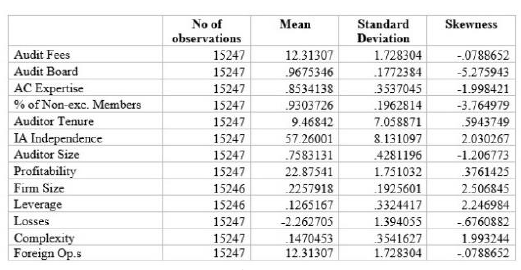
Table 2: Descriptive